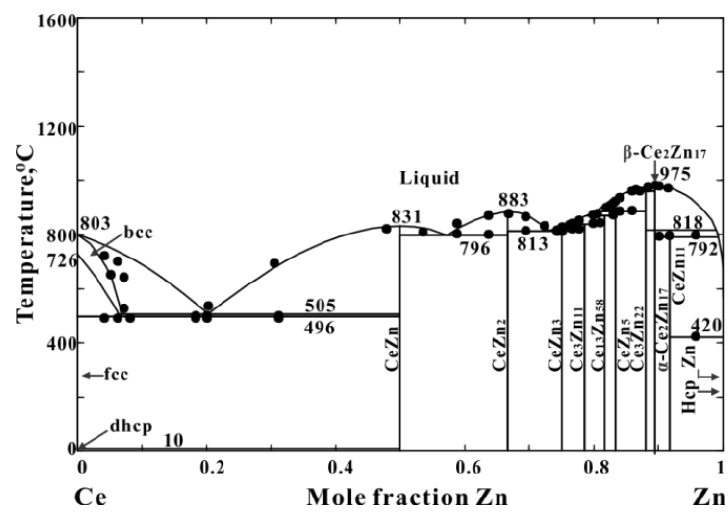
Figure 3. Zinc–cerium phase diagram calculated by [109].